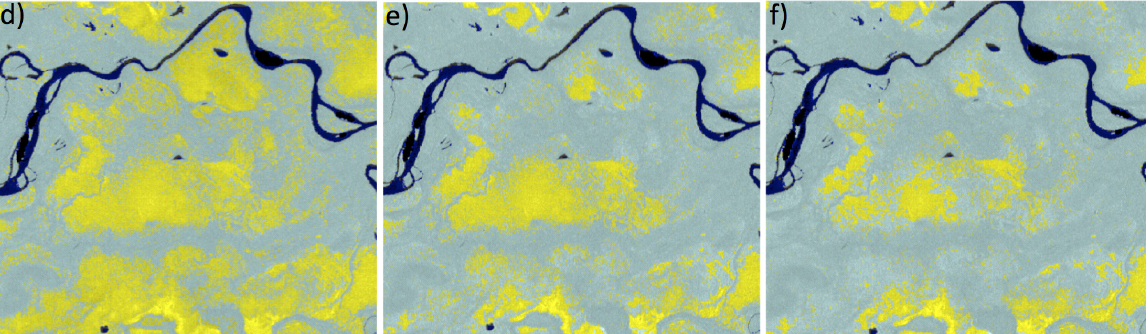
Figure 13. Classification overlaid on low contrast multi-temporal image mosaic of the area within the box from Figure 12 for specific ScanSAR observations acquired from the same path orbit, at letter “c” in Figure 3. Area shown is 45 km by 45 km. ( a ) 29 January 2007; ( b ) 16 March 2007; ( c ) 1 May 2007; ( d ) 16 June 2007; ( e ) 1 August 2007; ( f ) 16 September 2007. Yellow is inundated vegetation on the date of observation; black is open water. Area shown is 2000 km 2 .